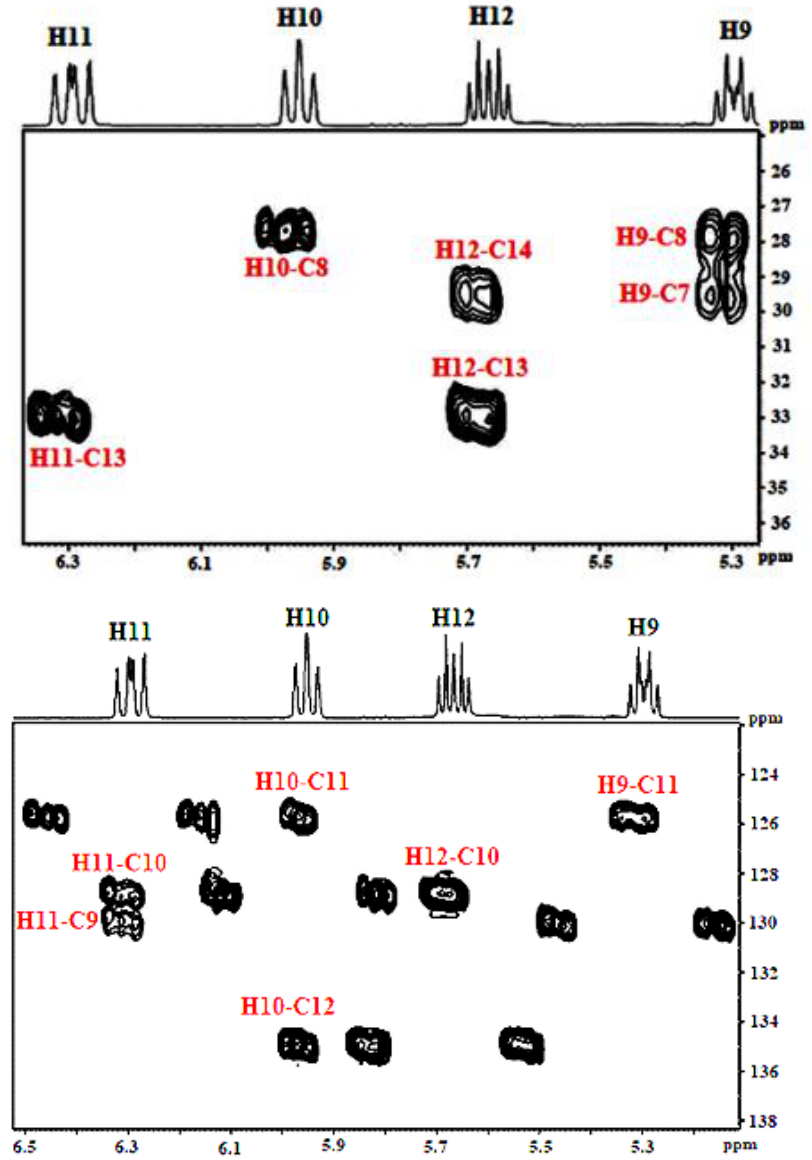
Figure 21. Selected region of 500 MHz 2D 1 H- 13 C HMBC spectrum of the (9- cis , 11- trans ) 18:2 CLA isomer in CDCl 3 (solution conditions the same as in Figure 16). Total experimental time = 7 h 41 min.